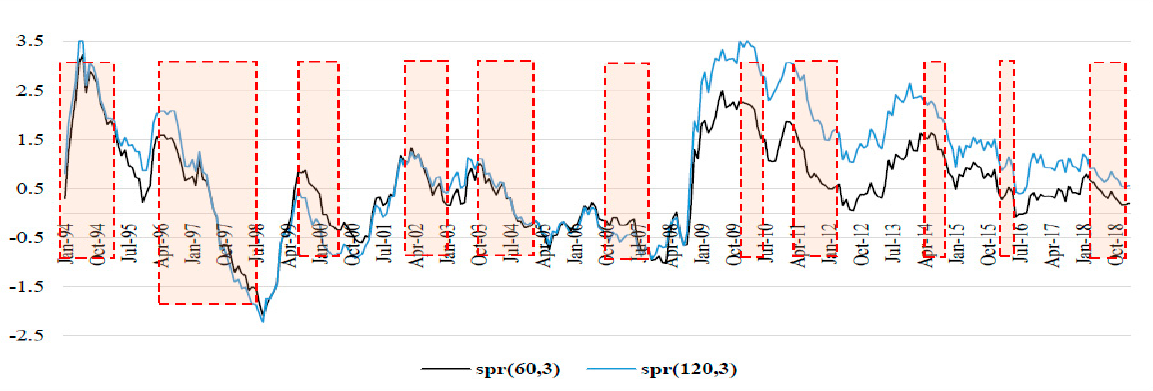
Figure 6. Yield spread-UK.